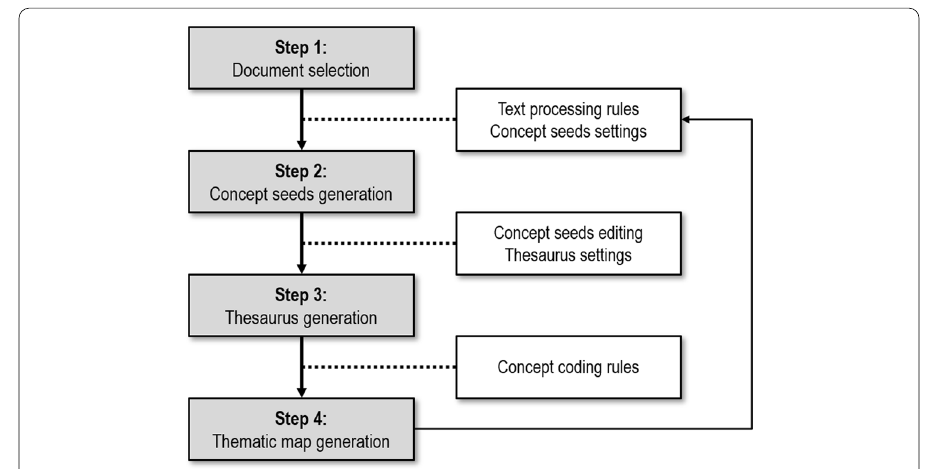
Fig. 1 Steps for defining and building a processing